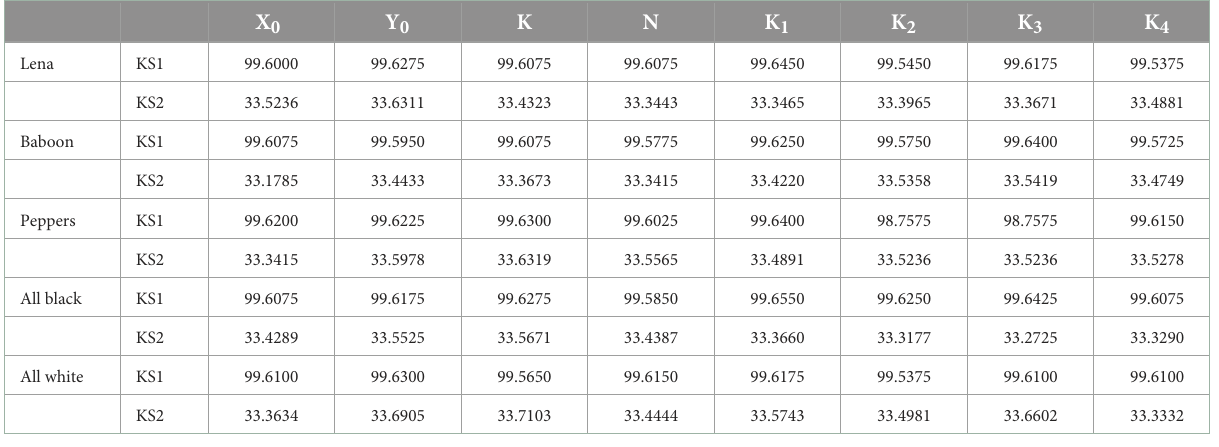
TABLE 14 Key sensitivity analysis results at the encryption level.